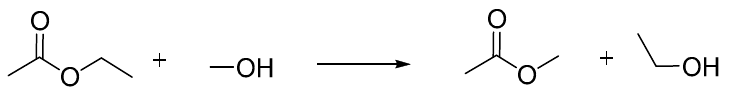
Table 1. Criteria for intrinsic kinetics of the transesterification between methanol and ethyl acetate in the (LS)² reactor, catalyzed by Lewatit K2629 at 60